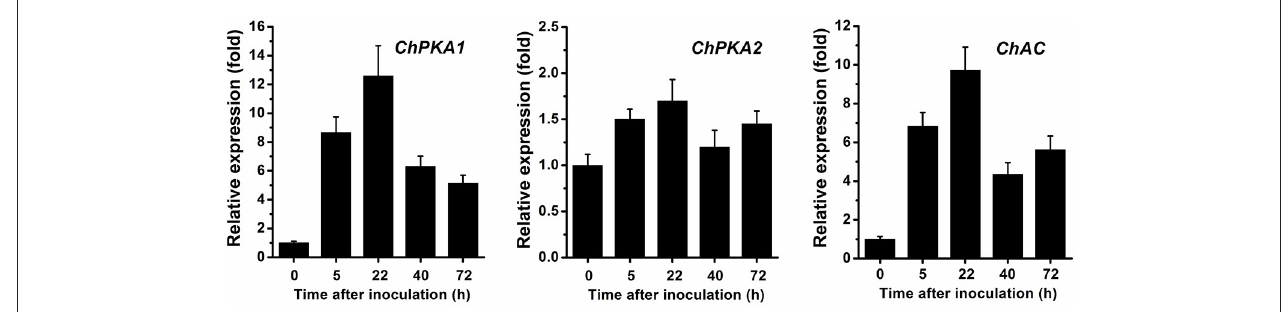
FIGURE 1 | Expression patterns of ChPKA1 , ChPKA2, and ChAC during infection stages were evaluated by qRT-PCR. RNA was extracted from infected Arabidopsis seedlings at 0hpi, 5hpi (conidial germination), 22hpi (appressorial formation), 40hpi (biotrophic infection stage), and 72hpi (necrotrophic infection stage), respectively. The genes expression of C. higginsianum conidia inoculated on Arabidopsis at 0h was set as level 1 and relative levels of transcript were calculated using the comparative Ct method. Transcript level of the C. higginsianum β -tubulin gene ( CH063_04743 ) was used to normalize different samples. Data represent means and standard deviations of three independent replications.